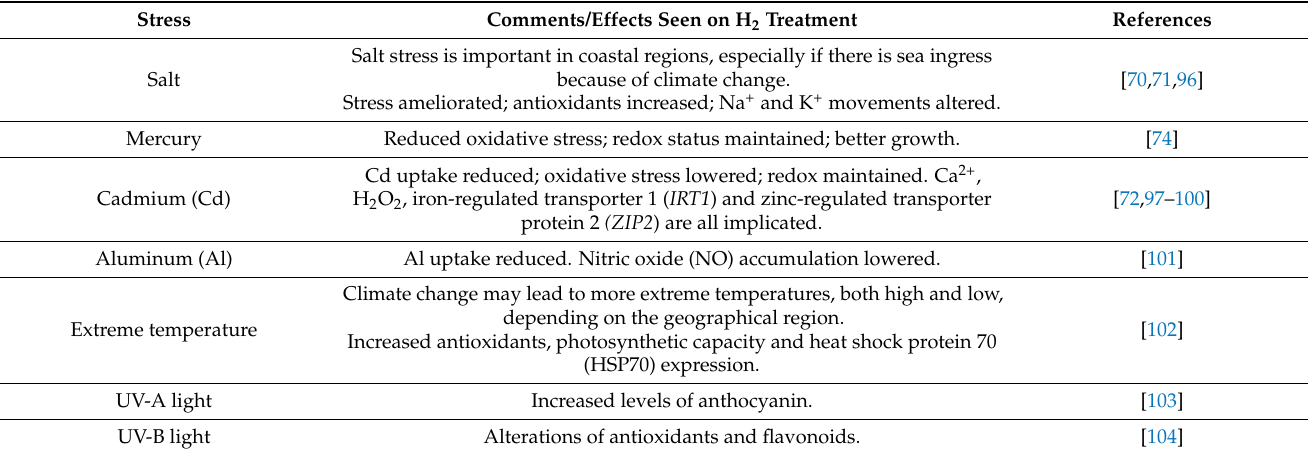
Table 2. A selection of plant stresses and the effects of molecular hydrogen.